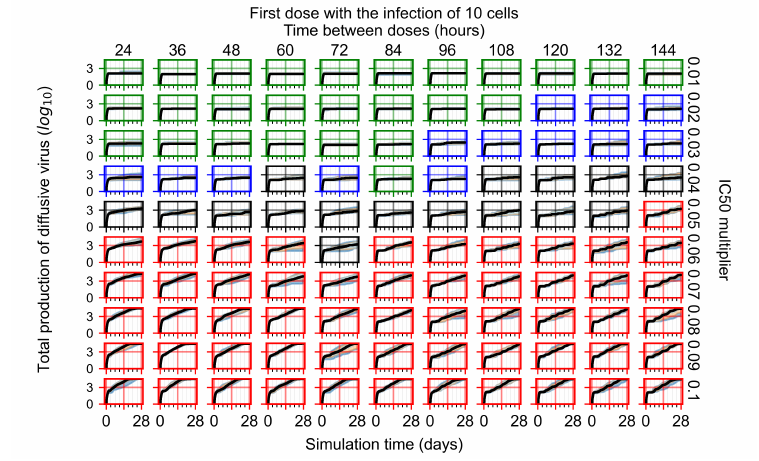
Figure A80. Total diffusive virus produced (AUC) for eight replicas of the treatment simulation, Y axis in log scale, and exponent values as tick marks.